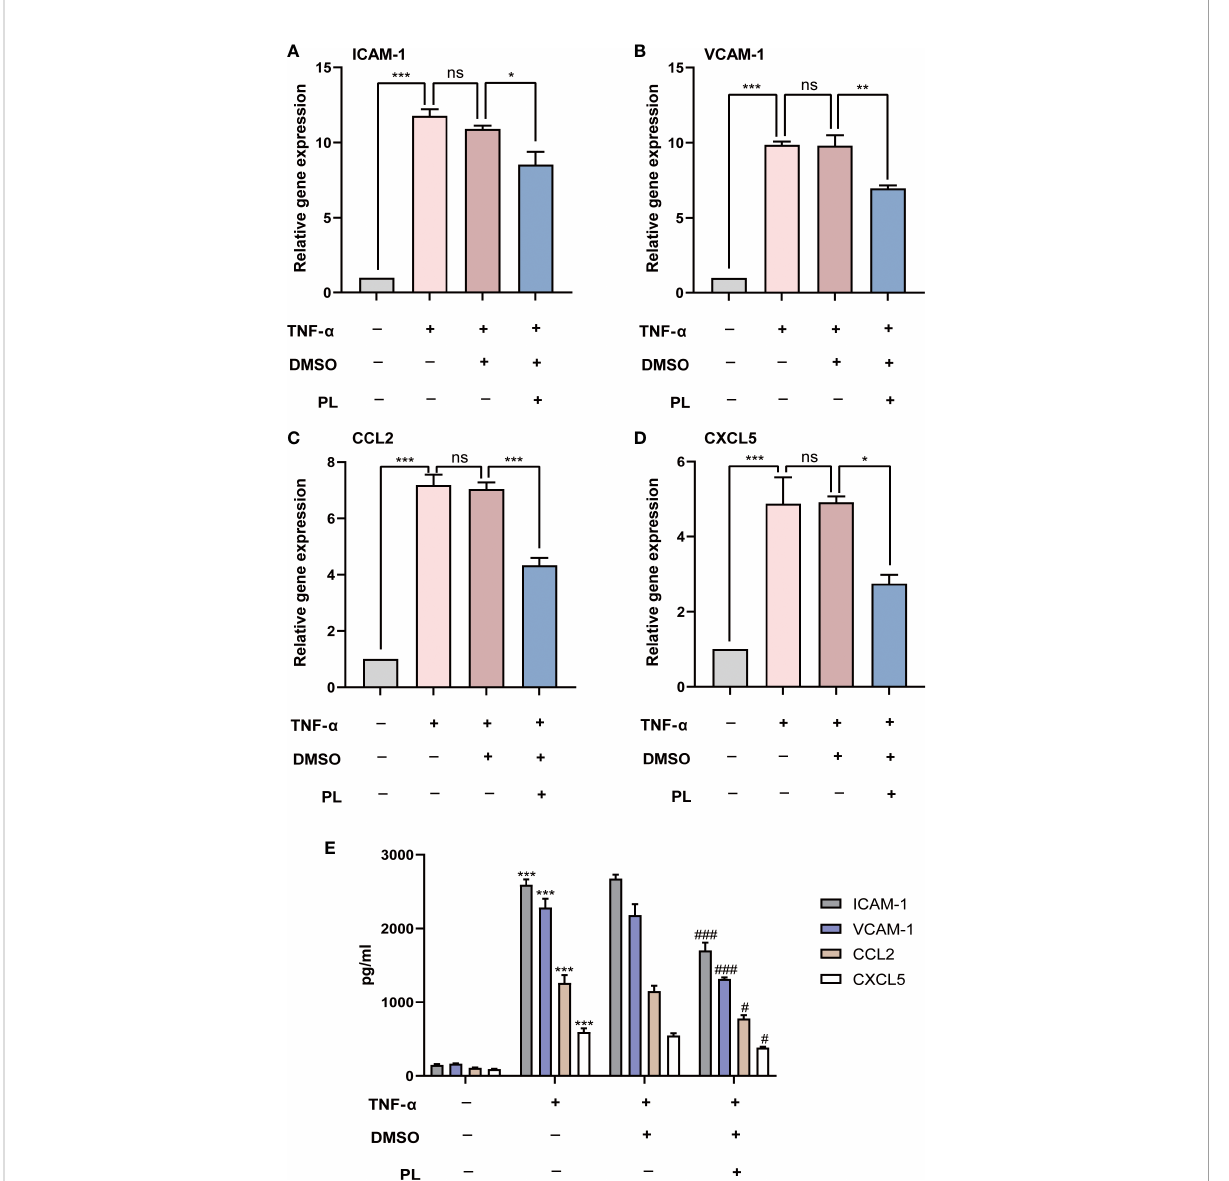
FIGURE 5 PL inhibited TNF- a -induced expression of adhesion molecules and pro-in fl ammatory chemokines in HUVECs. (A – D) HUVECs were incubated under normal condition or TNF- a stimulation with or without PL. The mRNA expression levels of ICAM-1, VCAM-1, MMP-2 and MMP-9 were analyzed by qRT-PCR. Ns P > 0.05, *P < 0.05, **P < 0.01, ***P < 0.001. (E) The secretions of ICAM-1, VCAM-1, MMP-2 and MMP-9 in different groups were detected by ELISA. #, *P < 0.05, ###, ***P < 0.001. (# compares TNF- a 20 ng/ml conditions with normal condition and * compares PL 5 m M condition with 0.1% DMSO